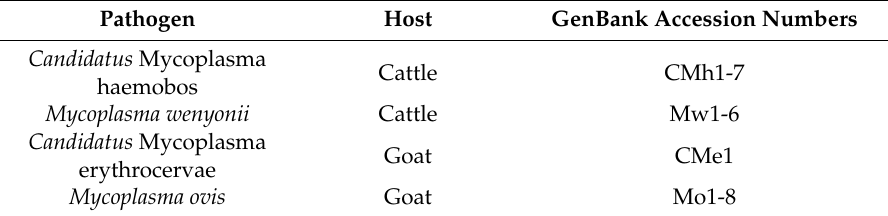
Table 4. GenBank accession numbers for the hemoplasma gene sequences obtained in this